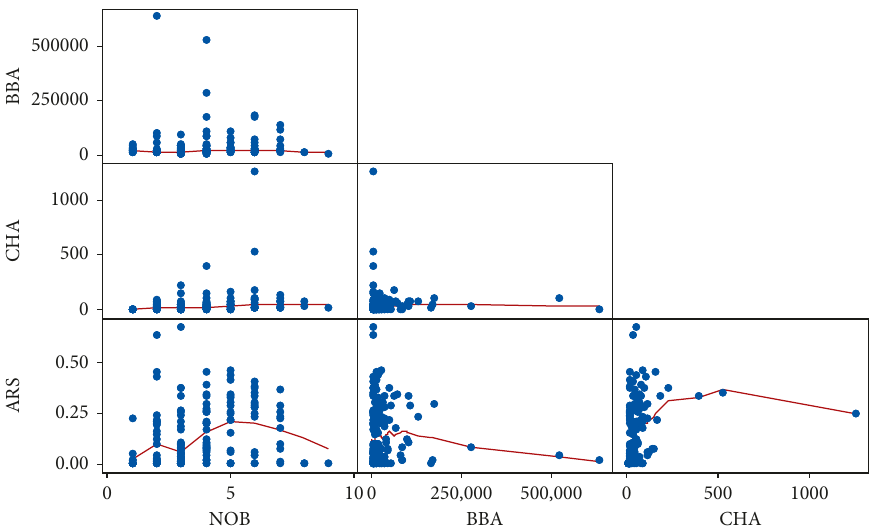
Figure 3: Matrix plots with lowess smoother for the NOB, BBA, CHA, and ARS variables in the construction e-RA dataset.